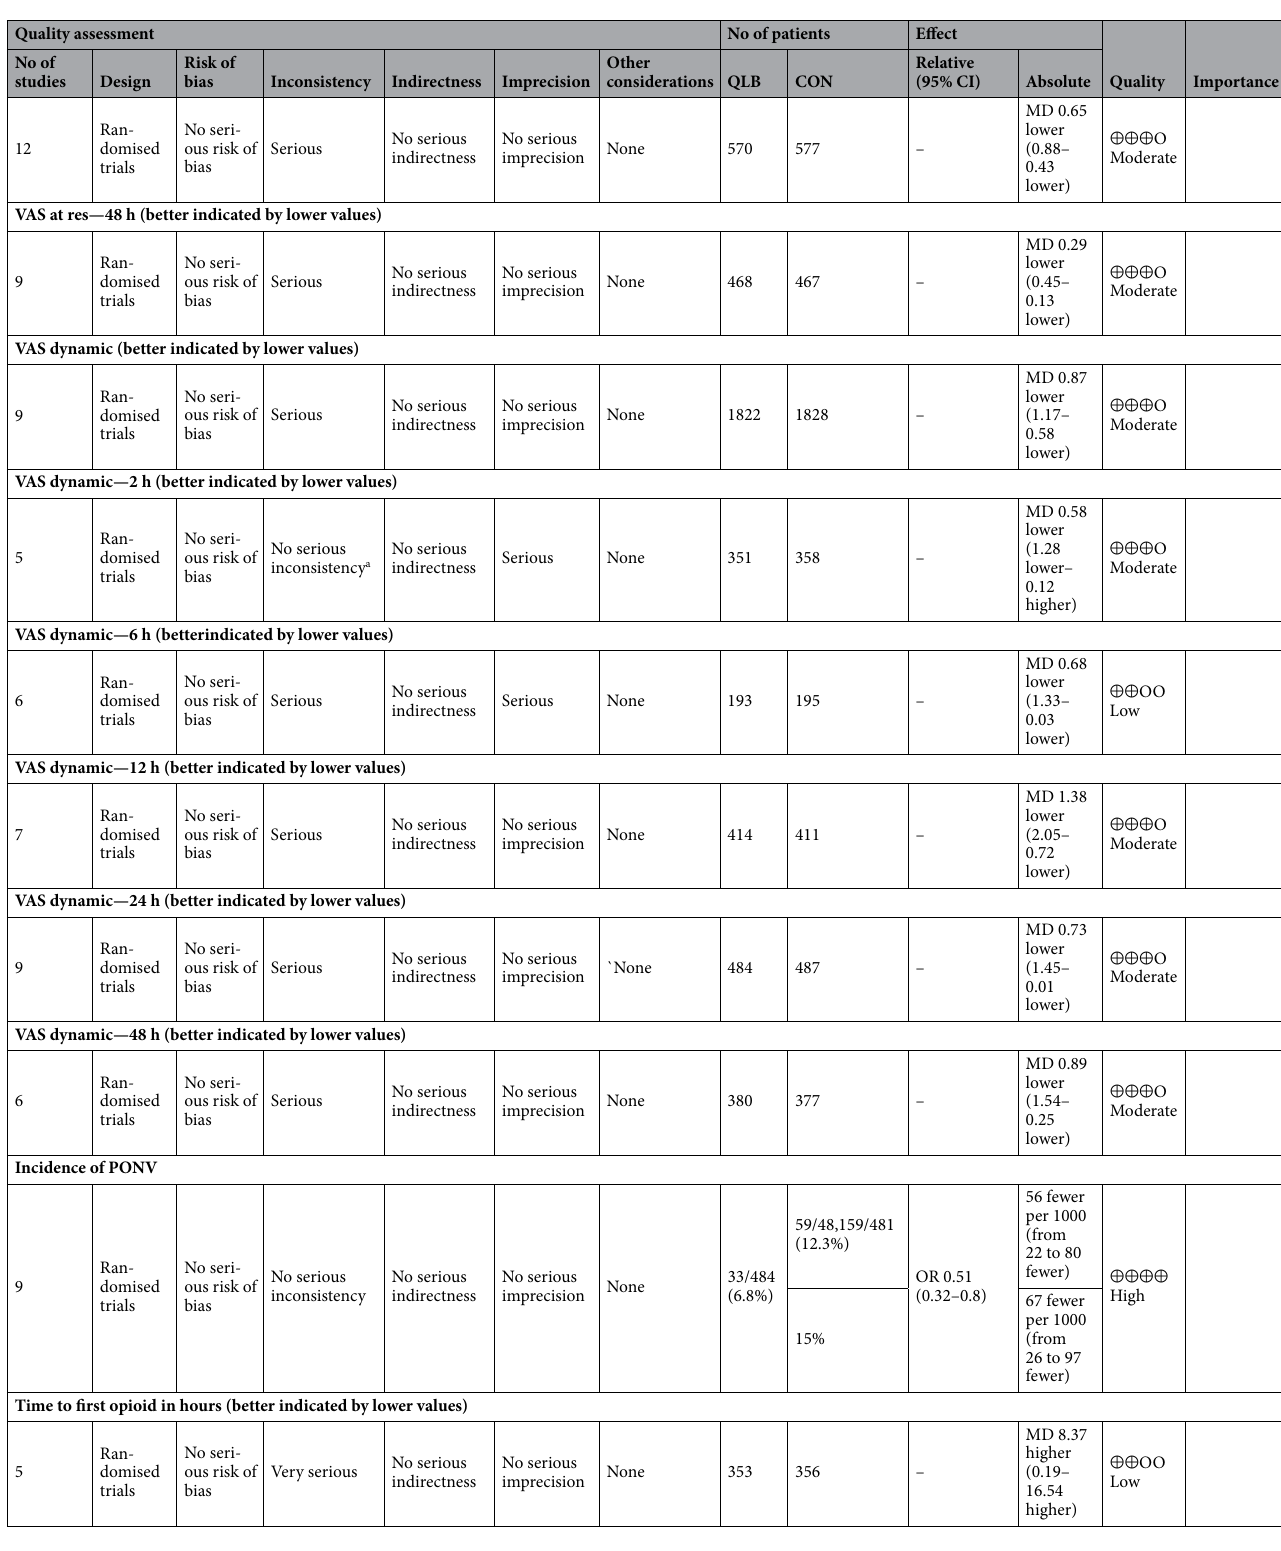
Table 2. Quality assessment of reported results by GRADE